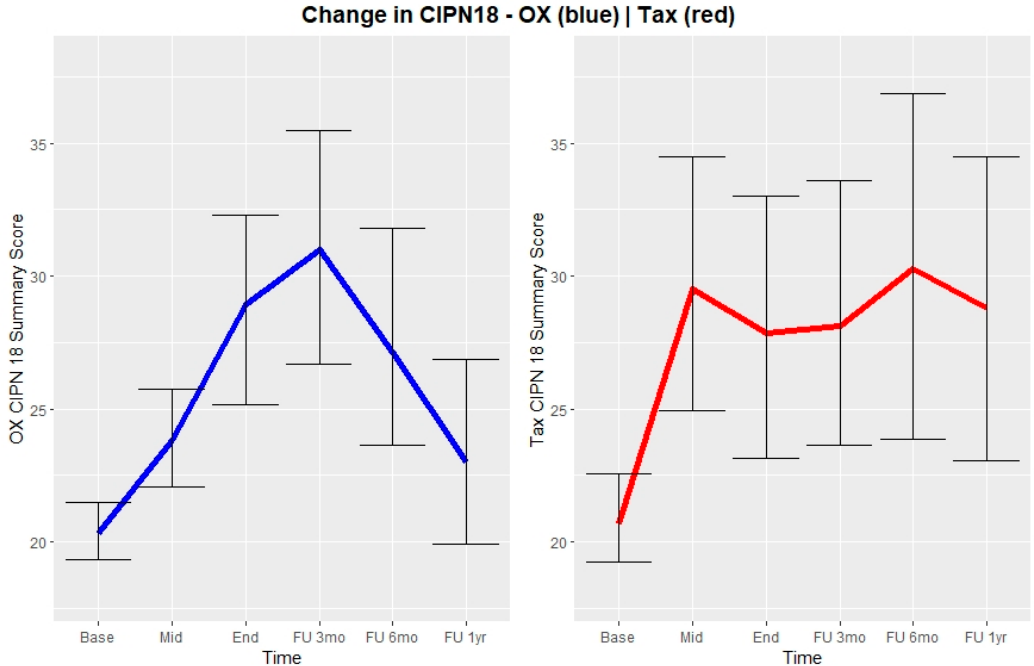
Figure 2. Development in patient mean CIPN18 scores from baseline to follow-up 1 year after end of treatment with corresponding 95% confidence intervals displayed as error bars. Left, blue: Depicts patients in CAPOX treatment. Right, red: Depicts patients in Carbo-Tax treatment.